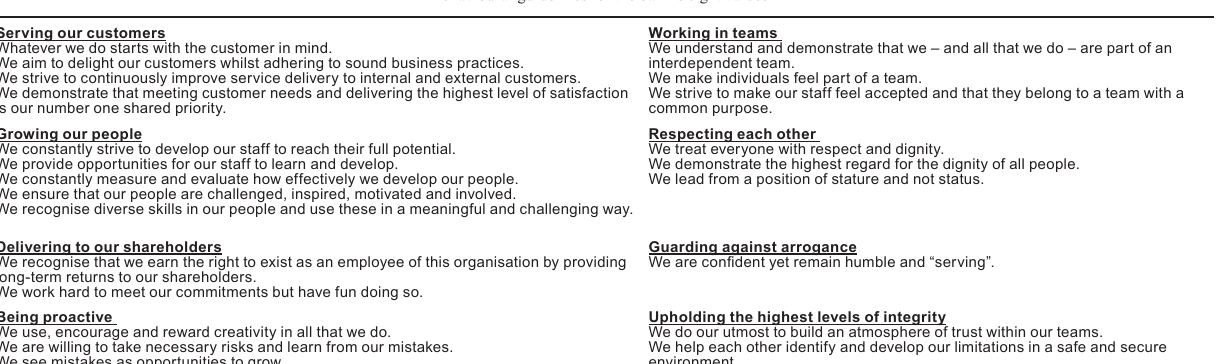
TABLE 2 Behavioural guidelines for the bank’s eight